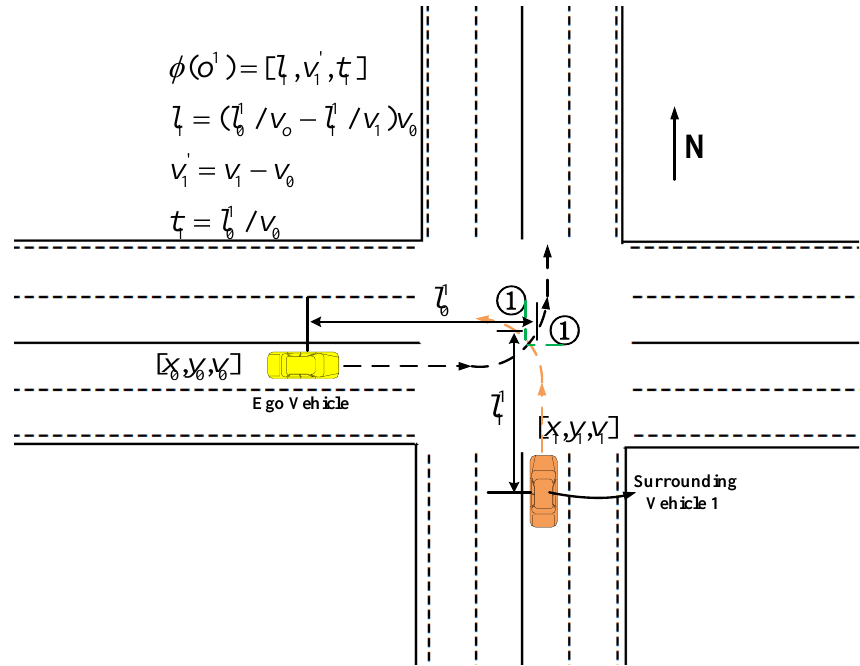
Figure 1. Description of collision relationship between an ego vehicle and one surrounding vehicle.